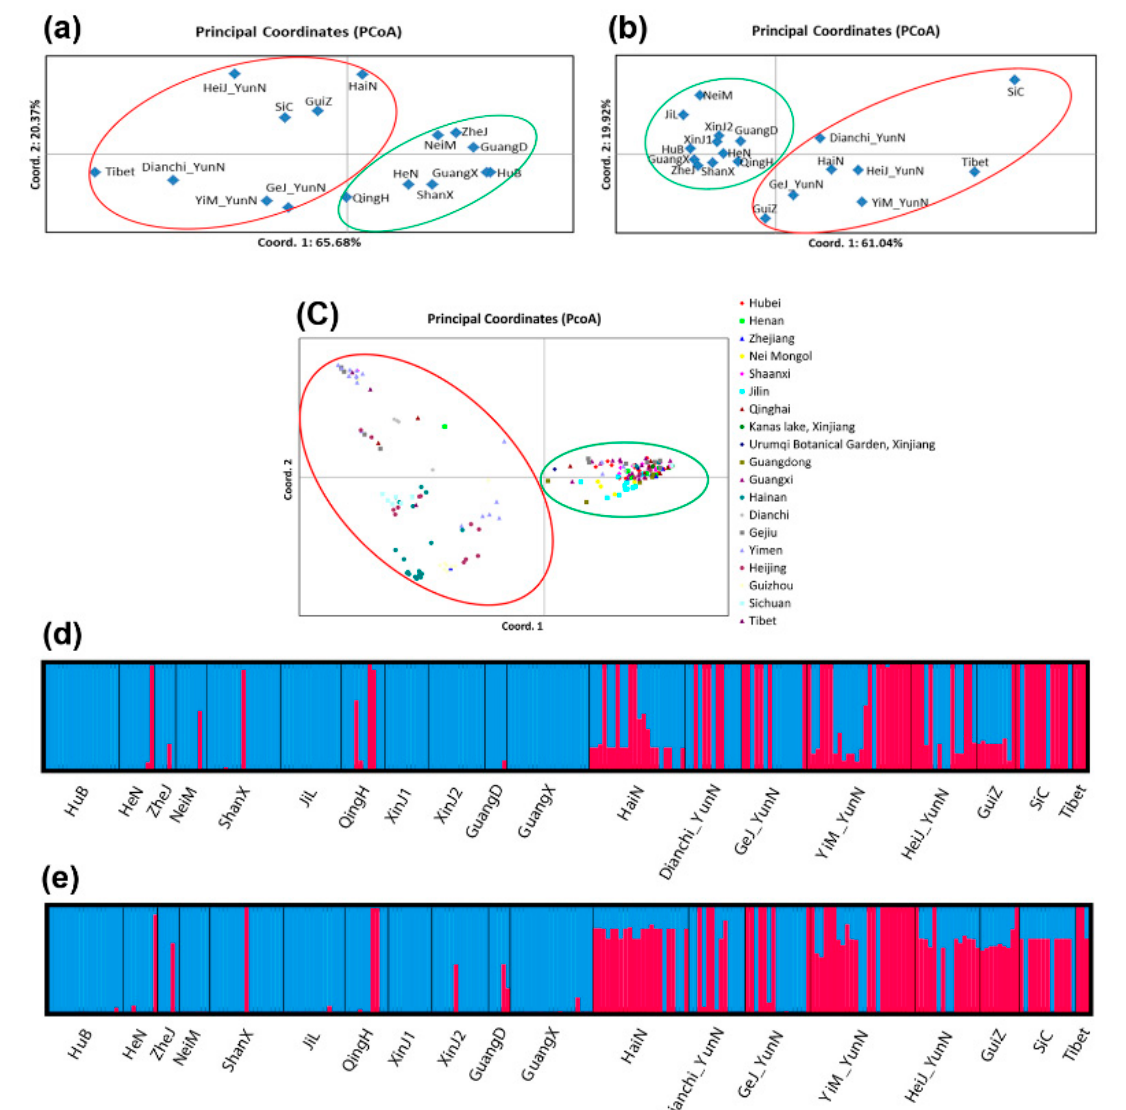
Figure 3. Genetic structuring results obtained from PCoA and STRUCTURE analyses. Analysis using MLST the dataset ( a , d ), the STR dataset ( b , e ), and the combined dataset ( c ).